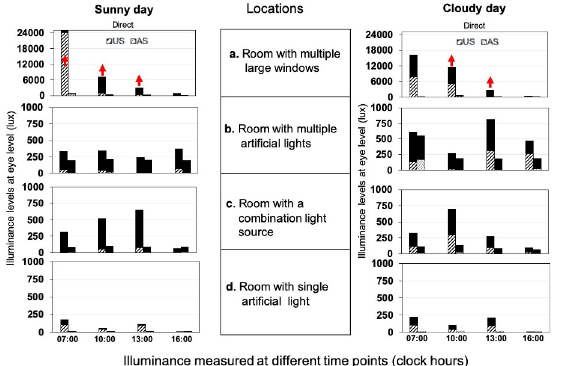
Fig 4. Illuminance levels recorded in four indoor locations on two sunny and cloudy days. US and AS sensor source positions recorded in four different time points in a day (07:00–08:00, 10:00–11:00, 13:00–14:00 and 16:00– 17:00 hours) in a sunny (left panel) and a cloudy day (right panel). The dark shaded area on the top of each bar represents the difference in illuminance level in two sunny and two cloudy days. The upward-facing arrows in red colour represent the illuminance level > 1000